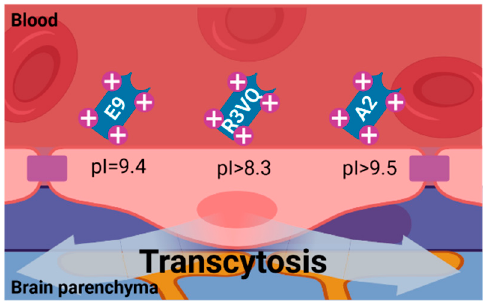
Figure 4. Nanobody BBB permeability due to Adsorptive-Mediated Transcytosis. The positive charged surface of single-domain antibodies (nanobodies and VNARs) with basic pI (~9.5) allow them to spontaneously interact with the cell membrane of the endothelial cells of the BBB, mediating their transcytosis into the brain parenchyma. Image created with BioRender.com (accessed on 17 June 2021).